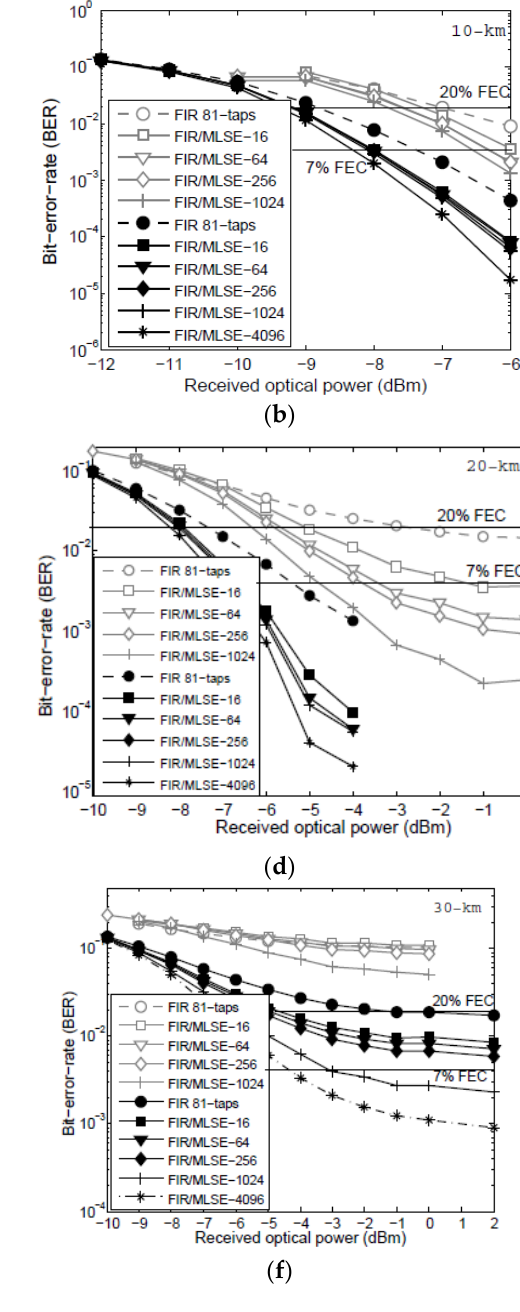
Figure 6. BER vs. received optical power for ( a ) 10-km; ( b ) 15-km; ( c ) 20-km; ( d ) 20-km; ( e ) 25-km; and ( f ) 30-km for the scheme of Figure 1a,b in black and in grey, respectively.